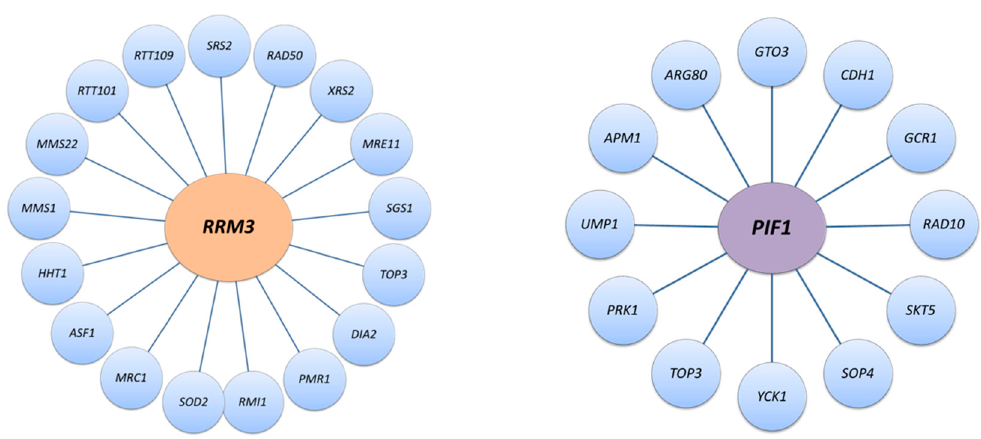
Figure 2. Synthetic lethal interactions of RRM3 and ScPIF1 [25,26,34,49,58–79].